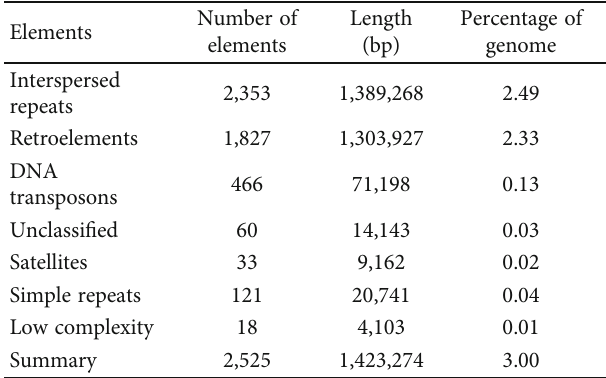
Table 5: Statistical result of repeated